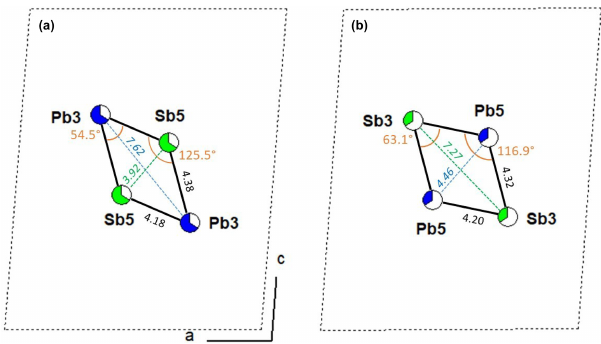
Figure 7. Comparison of lozenge geometry of the [(Pb,Sb)3] 2 [(Sb,Pb)5] 2 groups with the main and minor sub- stitutions ( a and b , respectively) in fülöppite (sample F2).